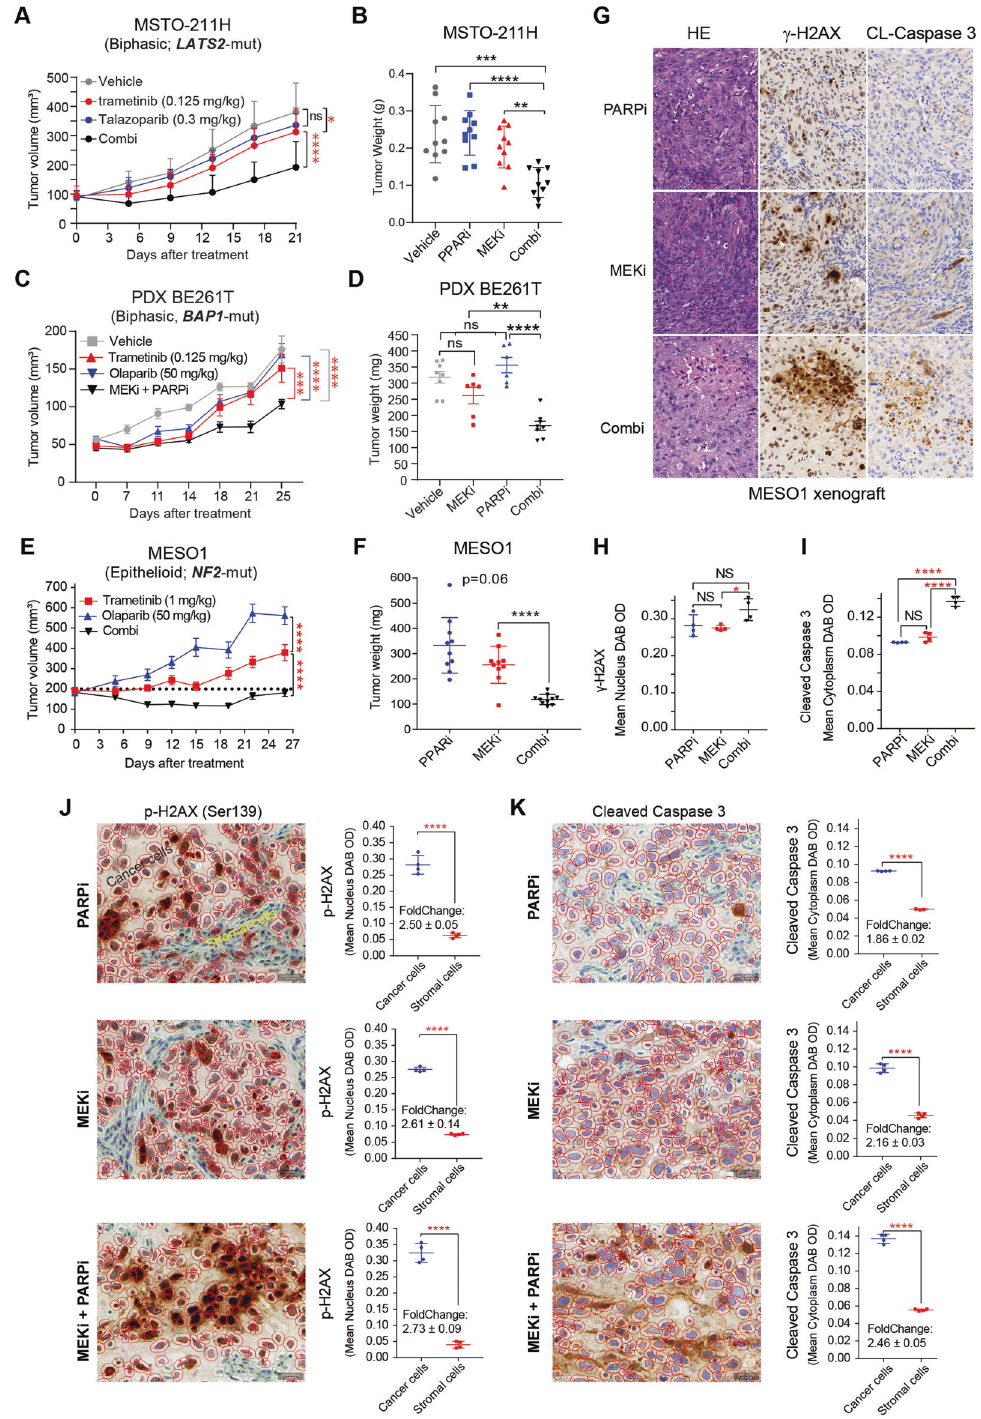
Fig. 7 Combined MEKi/PARPi enhances DNA damage and apoptotic death of MPM cells in vivo. A – F Growth curves ( A , C , E ) and tumor weights ( B , D , F ) of MSTO-211H and MESO-1 xenografts and a patient-derived xenograft (PDX, BE261T) treated with MEKi (trametinib), PARPi (talazoparib or olaparib), alone and in combination. Data are presented as mean ± SEM. * p < 0.05, **** p < 0.0001 by two-way ANOVA. NS non- signi fi cant. Note that the ef fi cacy of trametinib (1 mg/kg) as monotherapy has been assessed in MESO-1 xenografts (Fig. S1F), so the vehicle was not repeated here according to the 3 R principle of animal experimentation. G – I H&E and IHC ( γ -H2AX and Caspase-3) of residual tumors from MESO1 xenografts ( G ), with quanti fi cations of γ -H2AX and Caspase-3 levels shown ( H , I ). * p < 0.05, **** p < 0.0001 by two-way ANOVA. Original overall magni fi cation, × 50. J , K IHC staining and quanti fi cation of γ H2AX ( J ) and cleaved Caspase 3 ( K ) in residual MESO-1 xenografts after being treated with PARPi, MEKi, and the combination. Four tumors/group were randomly chosen for the analysis, with the quanti fi cation of γ -H2AX (nucleus OD value) and cleaved caspase 3 (cytoplasm OD value) based on the whole tissue slide. Representative images (200x) showing the arti fi cial intelligence-based detection of cancer cells and the stroma marked with red and blue circles, respectively, by the QuPath software implementation. **** p < 0.0001 by Welch ’ s t